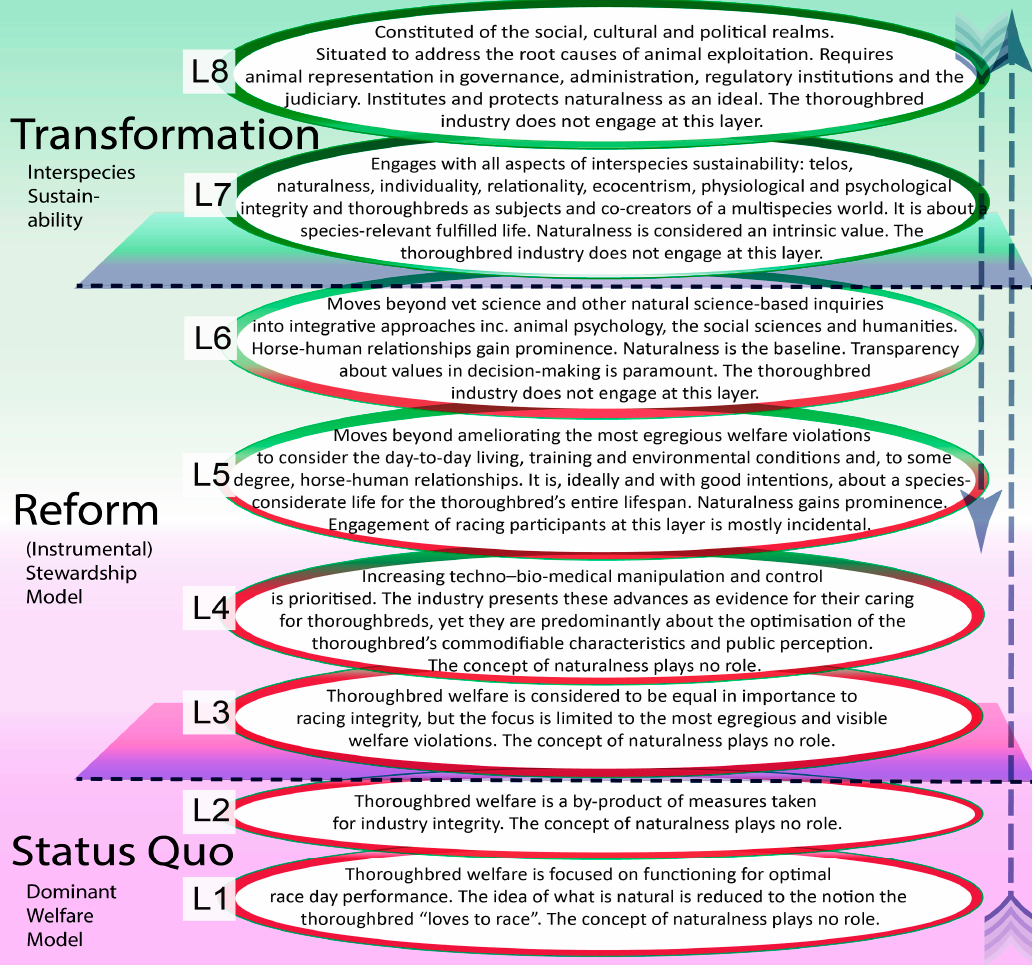
Figure 6. Layers of engagement with thoroughbred protection and the concept of naturalness. Indicates the status of the concept of naturalness within the discourse as described by Layer 1 to Layer 8 (L1–L8). The status of the thoroughbred industry discourse is situated within each layer. Eight layers were identified. They range from those layers striving to maintain the status quo (Layers 1 and 2) through reform (Layers 3–6) and to those aiming at transformation (Layers 7 and 8). There is no strict separation between the discourse affiliated with any layer. The discourse on a particular issue can move up and down these layers, and the layers can overlap. The layers are not necessarily exclusive but can be, and any of the layers can be engaged within a discourse concurrently. They can augment each other but, also, be contradictory and difficult or impossible to reconcile. It is important to be aware of at what layer(s) the discourse takes place. The layers were